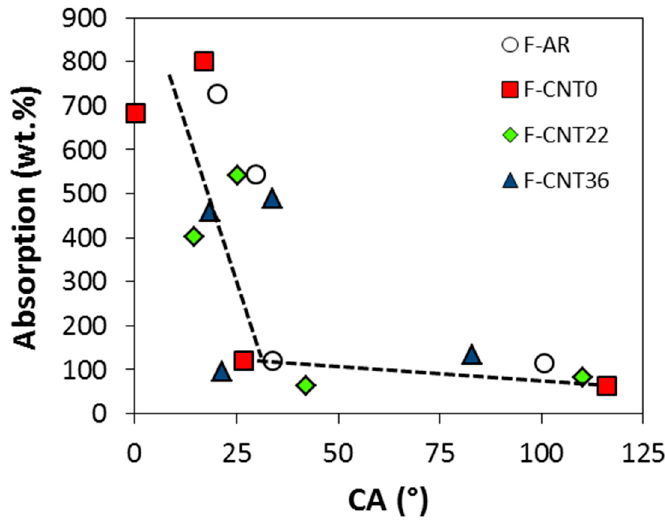
Figure 11. Correlation absorption (wt%) vs. contact angle (CA—(°)).